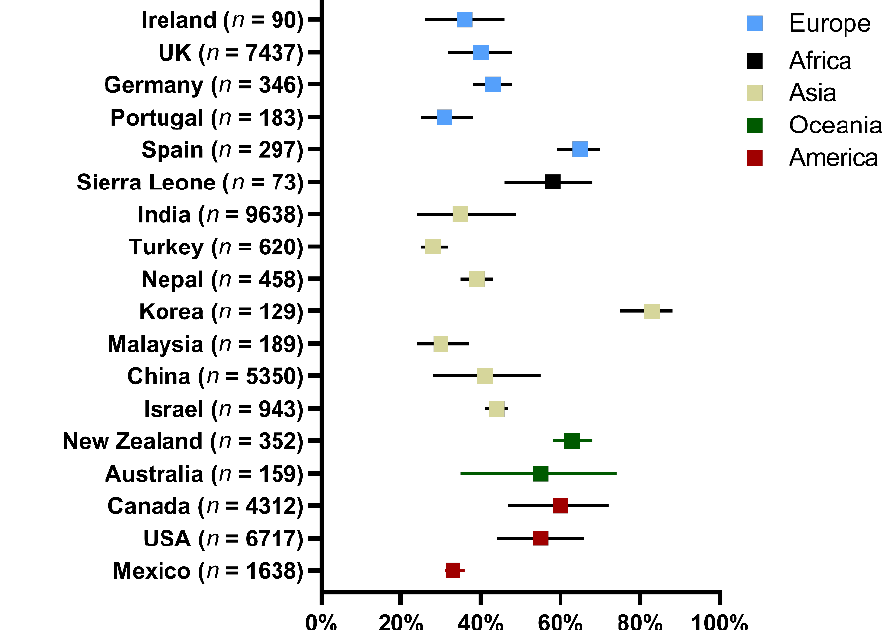
Figure 3. Positive rate of bacterial culture from corneal lesions in different regions.